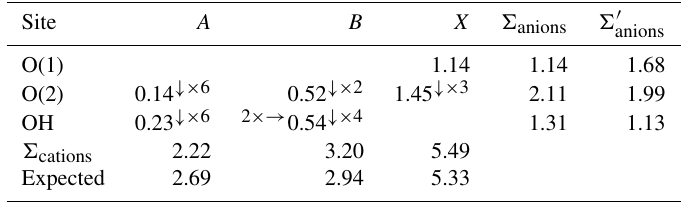
Note: left and right superscripts indicate the number of equivalent bonds involving anions and cations, respectively. (cid:54) (cid:48) is corrected for H bonds. Table 7. Comparison between graulichite-(La) and other REE-bearing dussertite group minerals. Arsenoflorencite-(Ce)